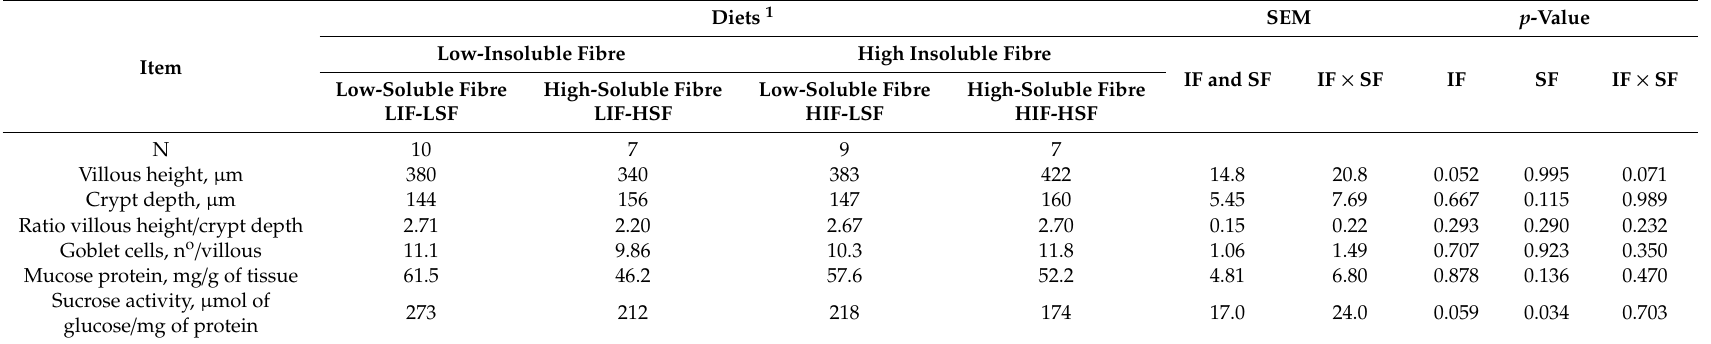
Table 7. E ff ect of dietary level of insoluble and soluble fibre on mucosa histology and enzyme activity of 39-day-old